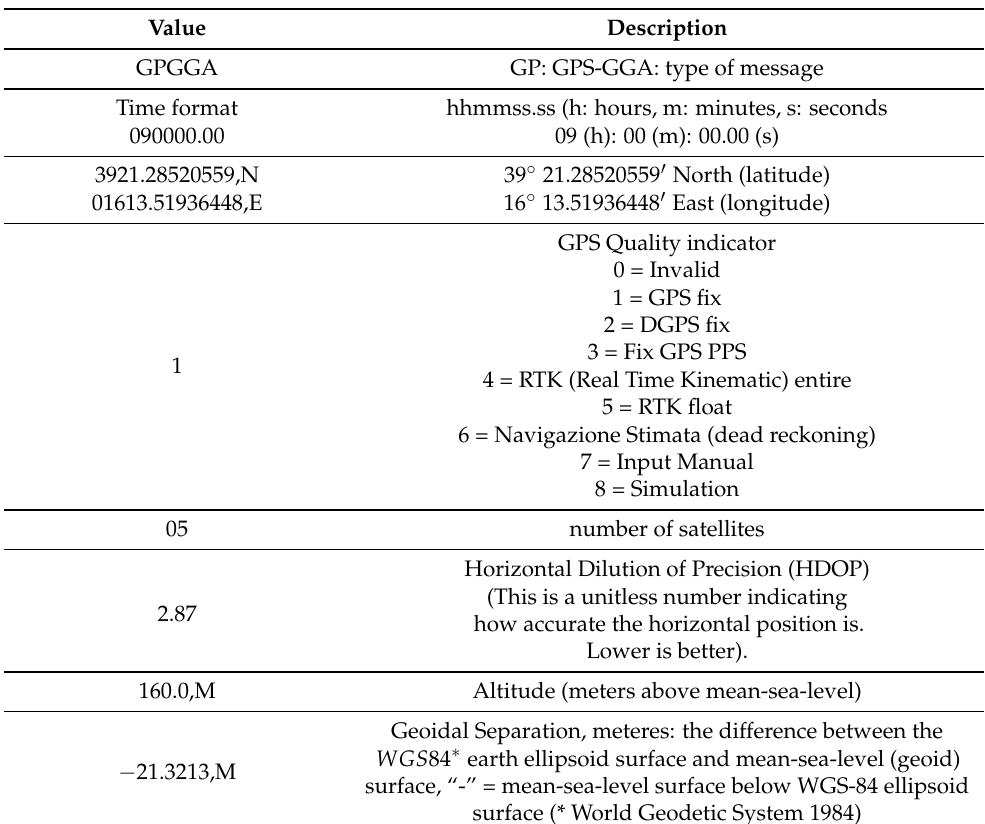
Table 2. NMEA GGA string